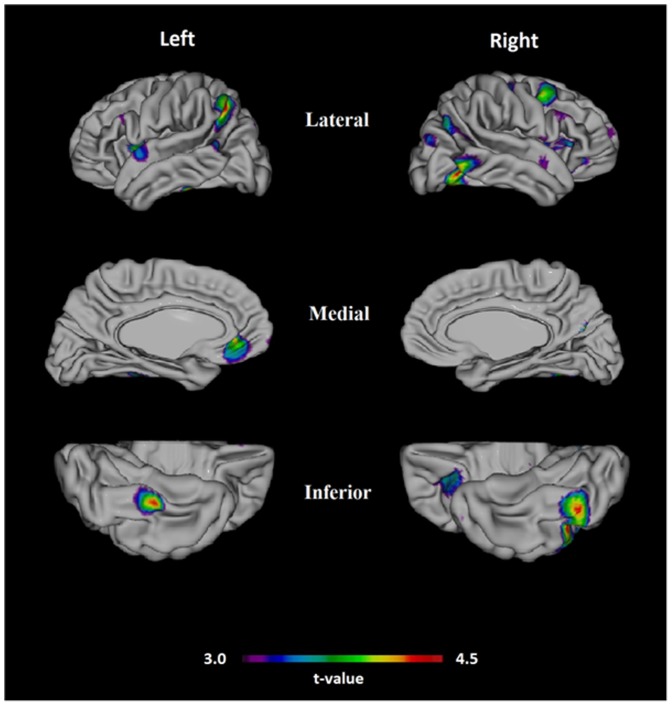
Statistical difference (t-value) maps of cortical thickness between CHD and control groups.Significant and FDR corrected (p<0.05) differences in cortical thickness between groups are displayed as color-labeled t-values on the surface of a standardized brain (warmer colors indicate thinner cortex). Analyses are adjusted for age, sex, follow-up time and scanner type.